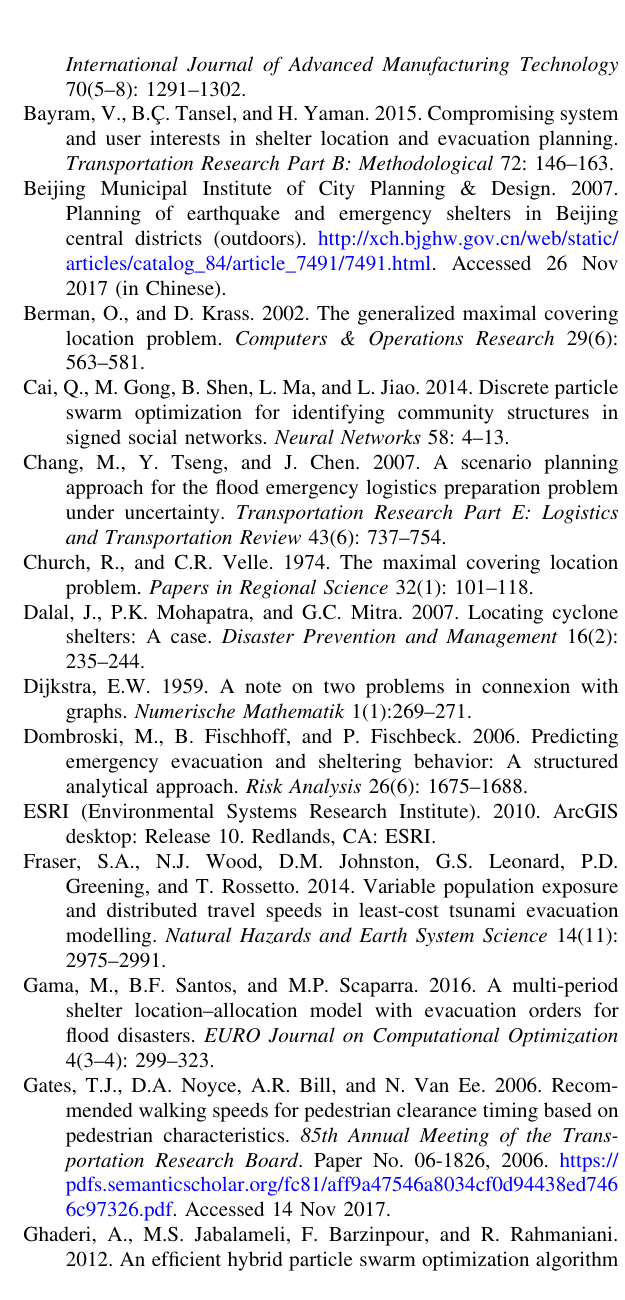
Fig. 14 Surface of evacuation population, total shelter area (TSA), and total weighted evacuation time (TWET) joint relationship. a – c Location 1, Location 2, and Location